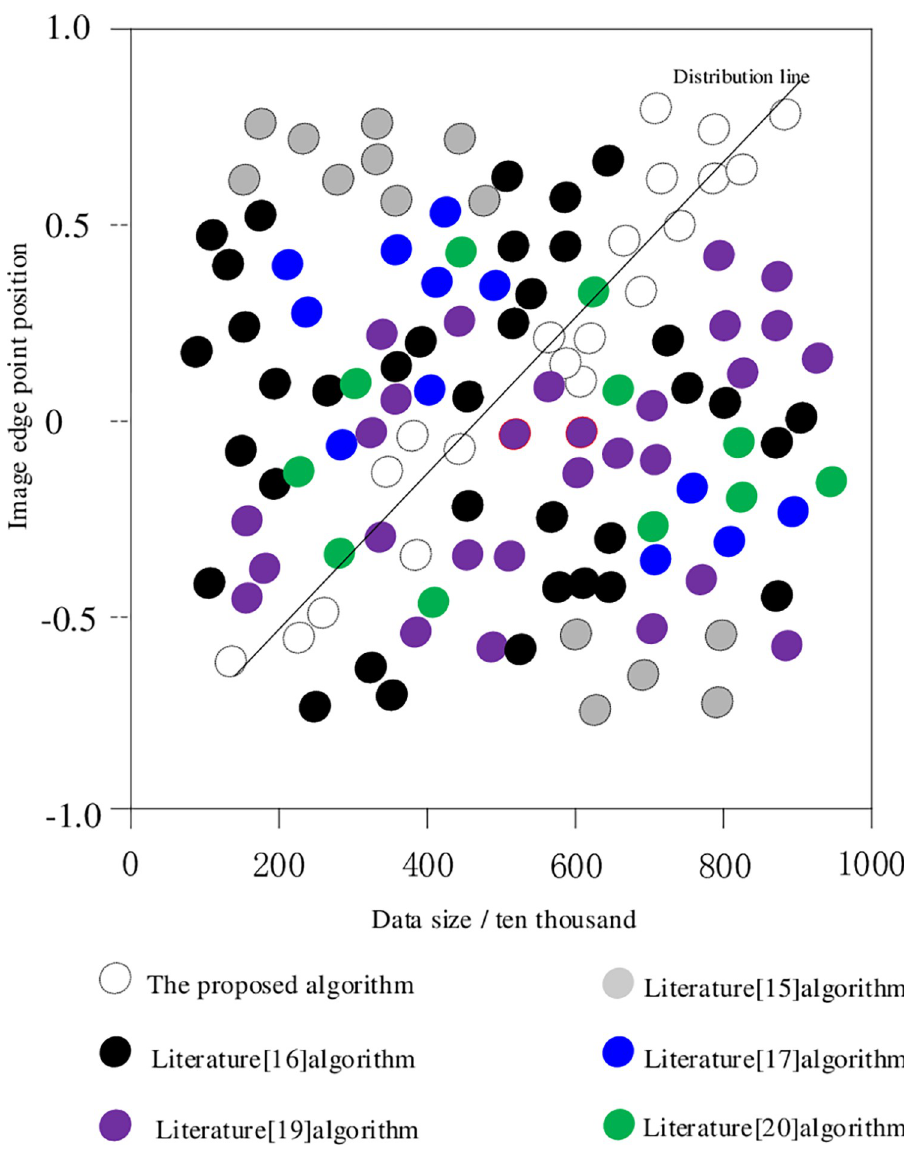
Fig 6. Comparison of distribution of image edge points.